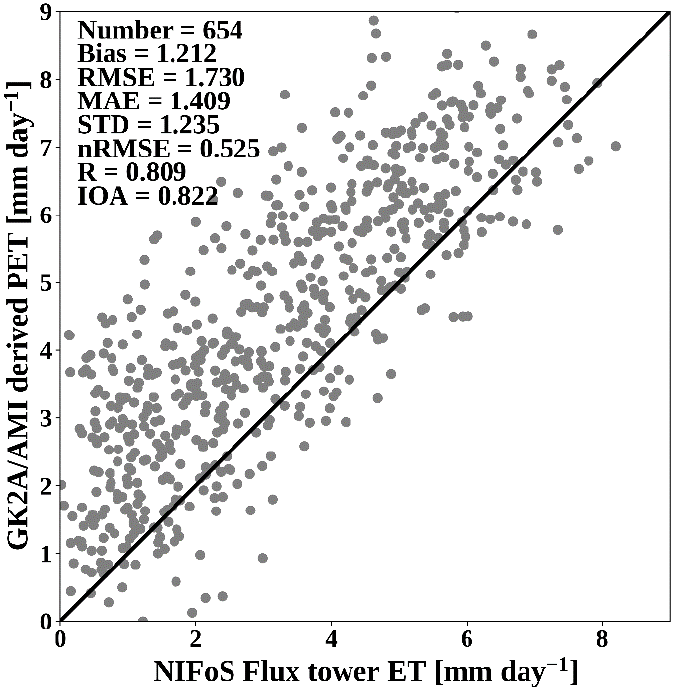
Figure 9. Comparison between GK2A/AMI satellite-derived and NIFoS flux tower-derived ET from